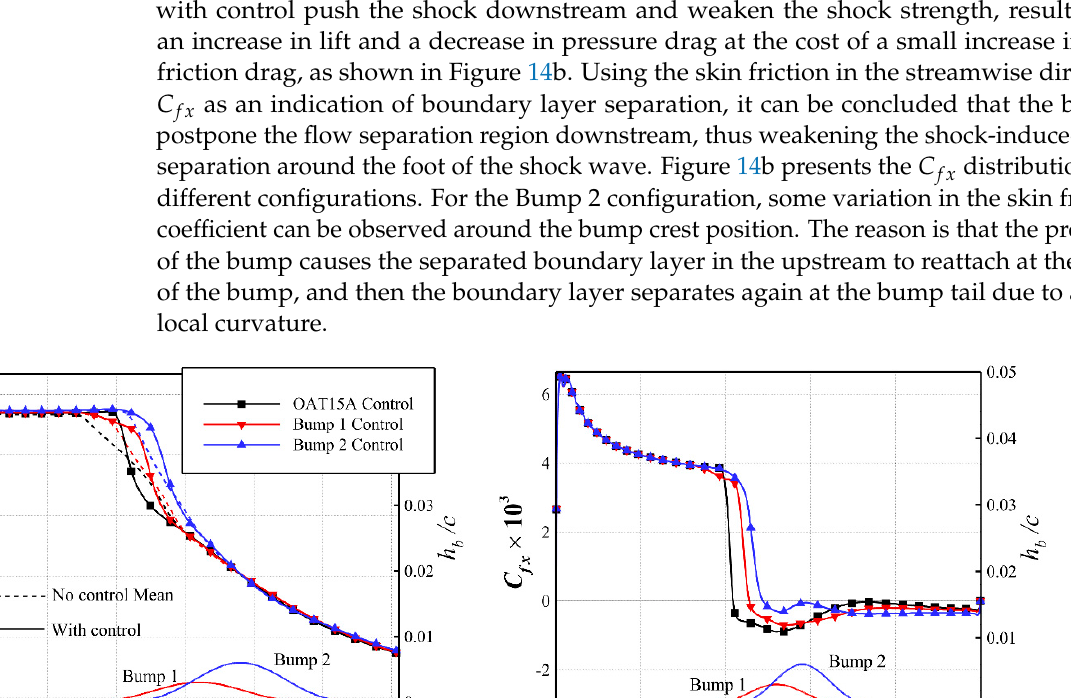
Table 5. Changes of aerodynamic coefficients for different configurations with and without the closed-loop flap control.